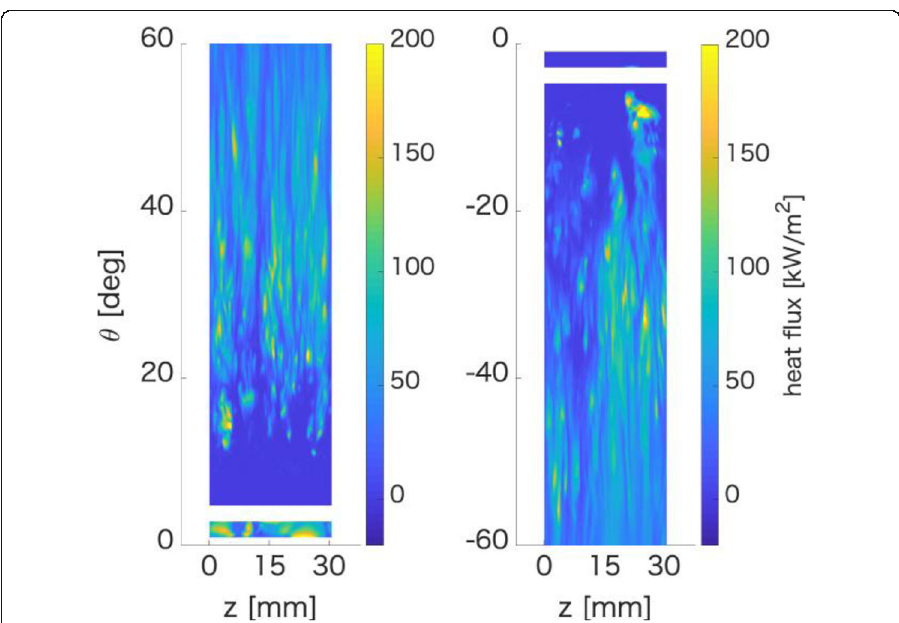
Fig. 6 A snapshot of heat flux distribution (Point B)